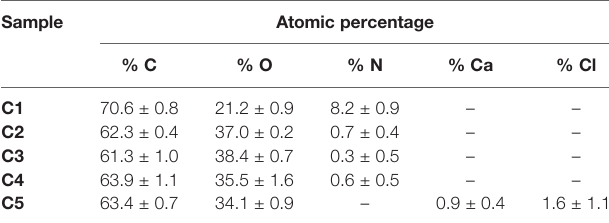
TABLE 4 | Average XPS atomic composition of the different